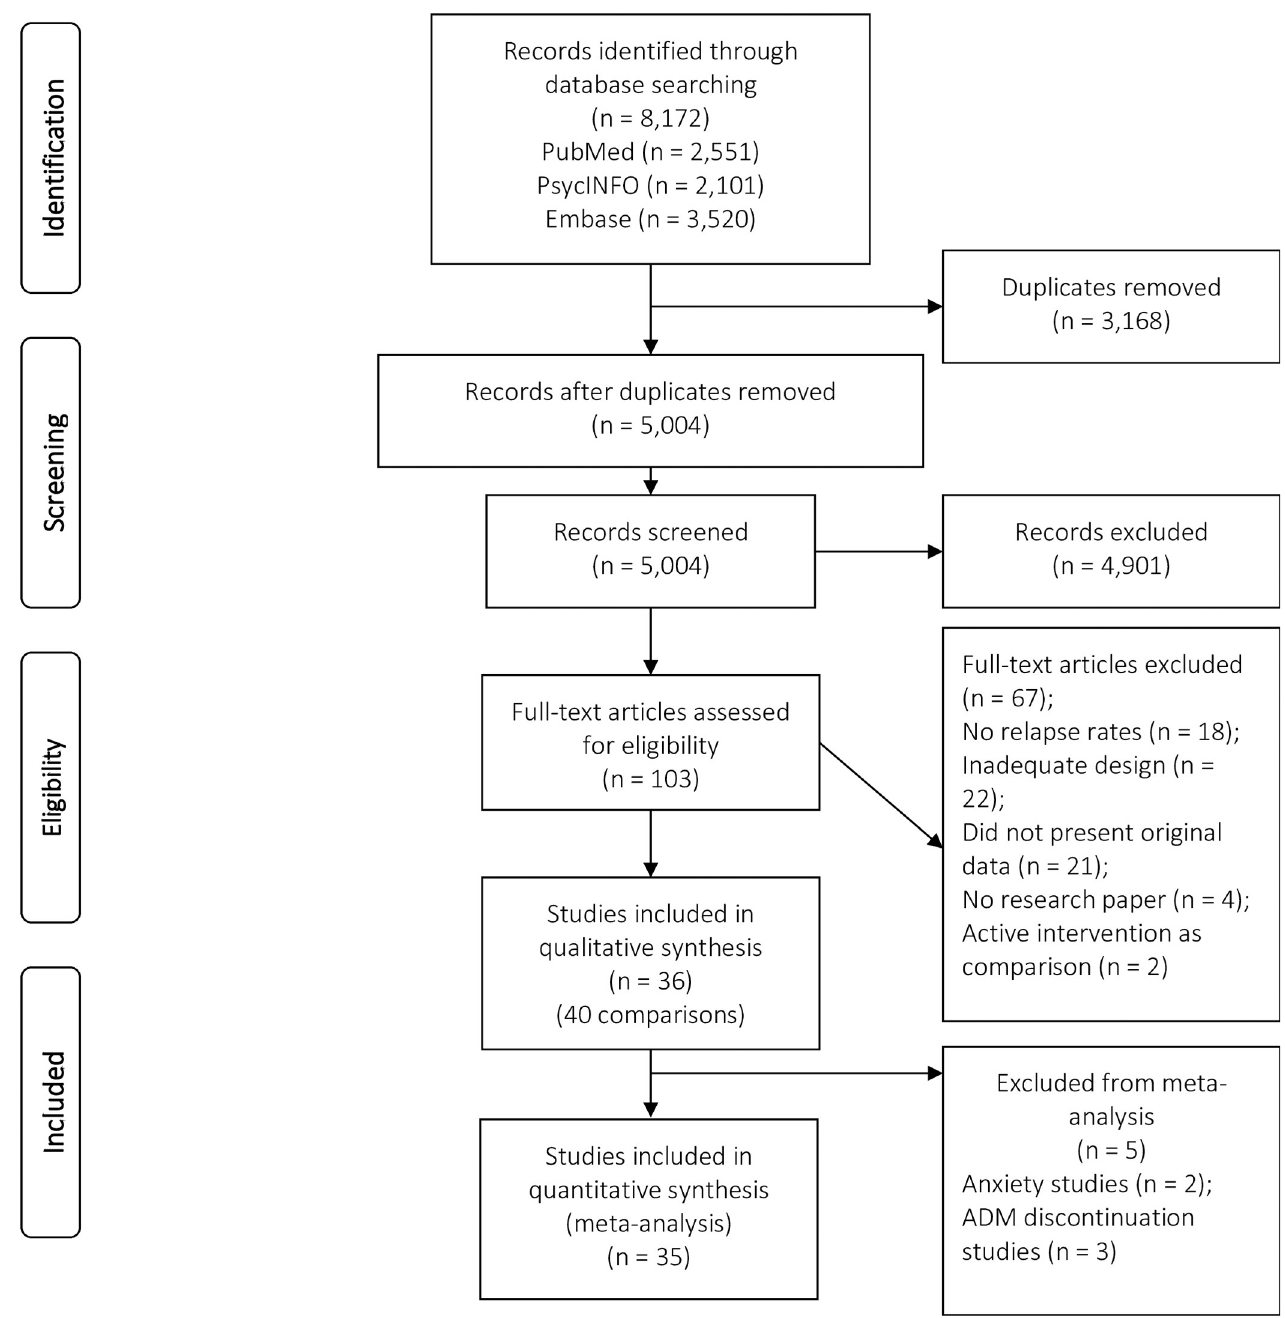
Fig 1. PRISMA flow diagram of the studies